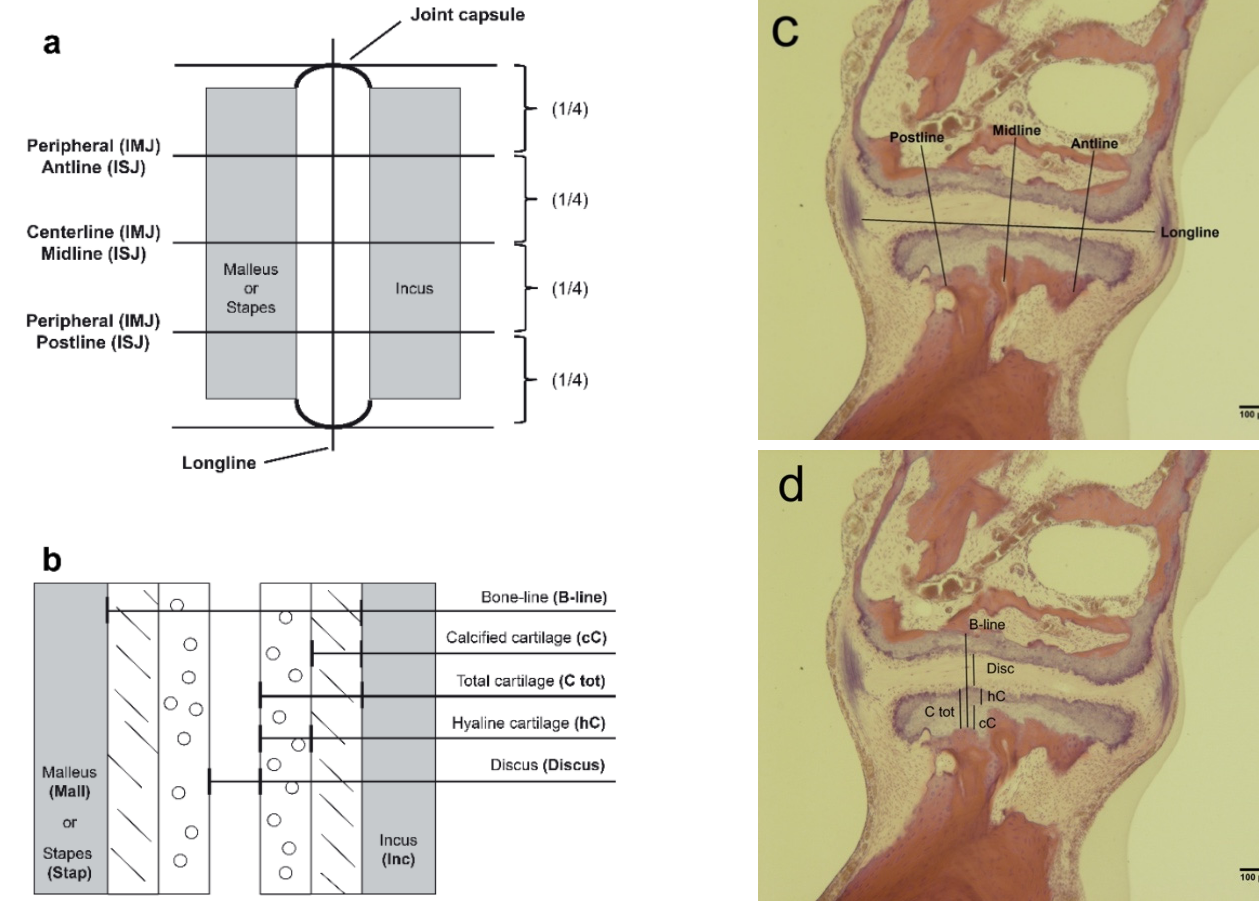
Figure 1. Graphical definition of the geometrical parameters defining the midsection of the incudo-malleal joint (IMJ) and the incudo-stapedial joint (ISJ), including lateral ( a ) and transverse ( b ) measurement positions for each joint (Fausch et al. [24]). Illustration of the parameters longline, midline, antline, and postline midsection of one representative incudostapedial joint ( c ), and B-line cC, C tot, hC and Discus ( d ).